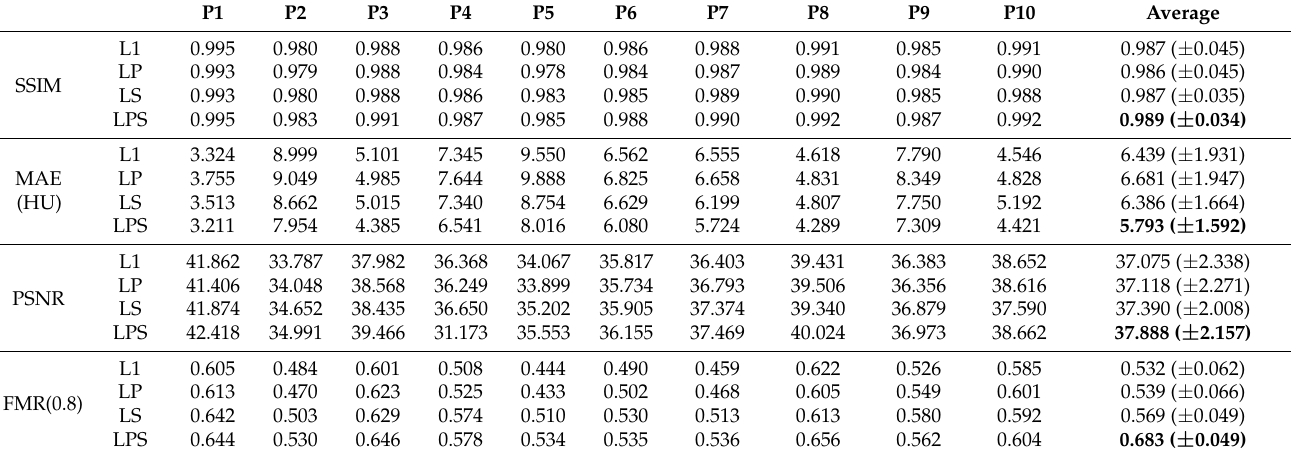
Figure 3. Examples of DL output images. True CT, CBCT, synthetic CT(L1 loss), synthetic CT(LP loss), synthetic CT(LS loss), and synthetic CT(LPS loss) from axial plane from one of the patients in the 10 test set. Table 2. SSIM, MAE (HU), and FMR performances for the DL outputs by generated from different learning losses for the 10 test